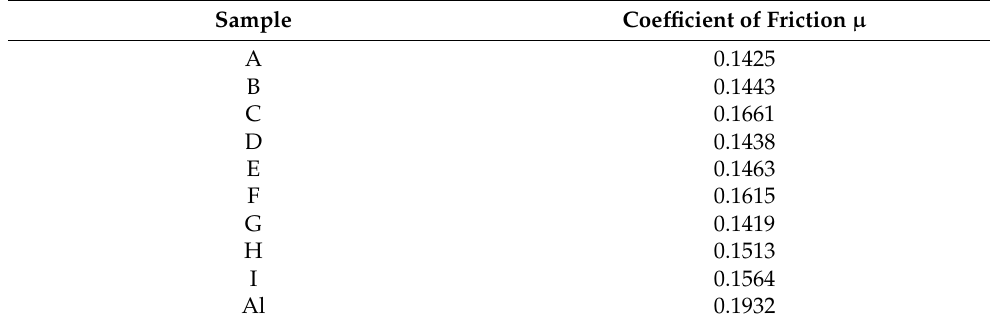
Table 3. The values of the coefficient of friction µ of the Al 2 O 3 layers and of the aluminum alloy when working with the T7W material.